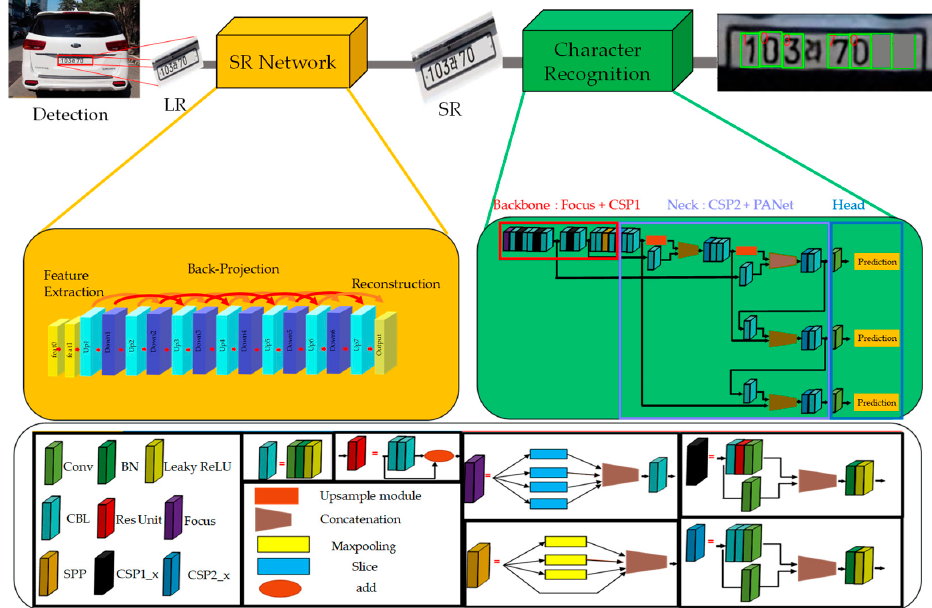
Figure 5. Flowchart of the integrated SR and character recognition. Two characters were masked due to privacy policies.